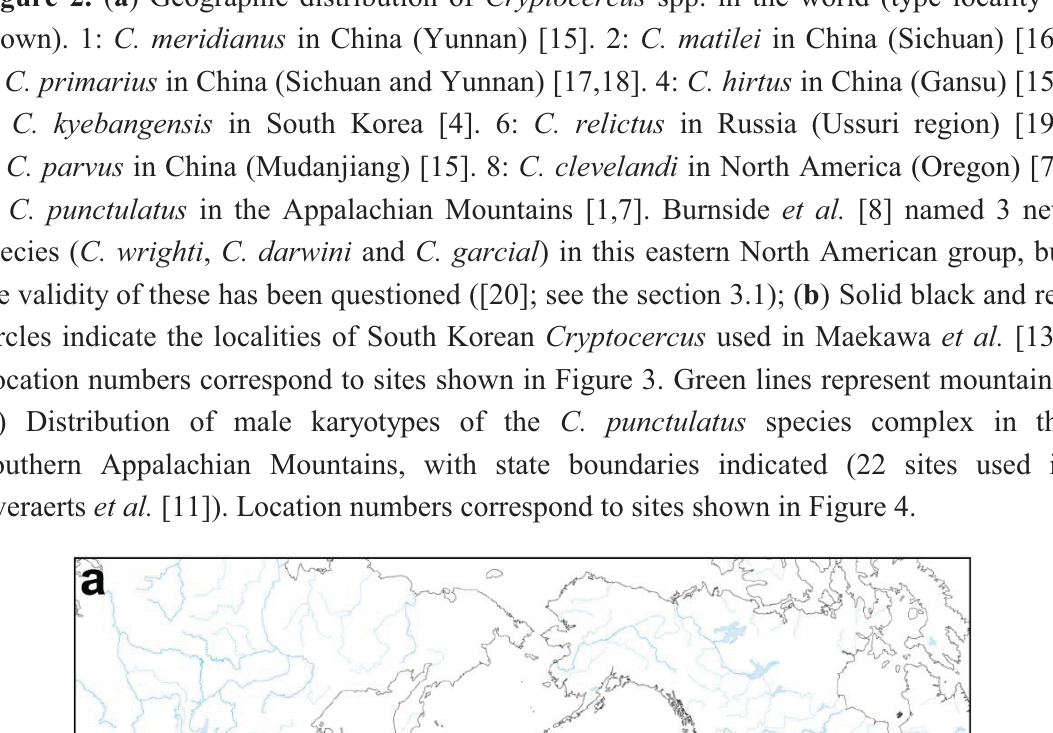
Figure 2. ( a ) Geographic distribution of Cryptocercus spp. in the world (type locality is shown). 1: C. meridianus in China (Yunnan) [15]. 2: C. matilei in China (Sichuan) [16].